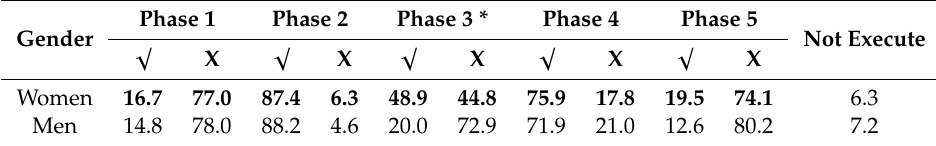
Table 4. Gender di ff erences in achievement level of cartwheel over eight academic years. Phase 1 Phase 2 Phase 3 * Phase 4 Phase 5 Gender Women